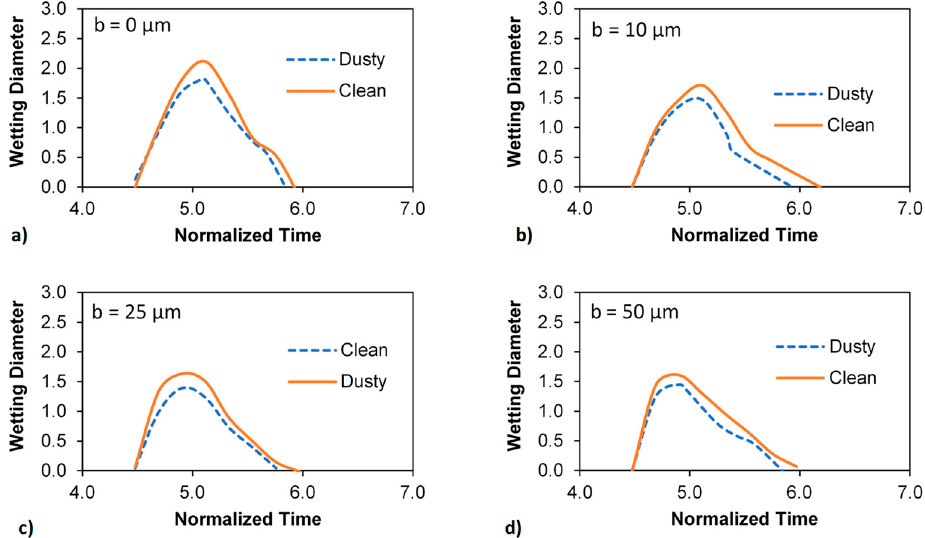
Figure 16. Variation of droplet wetting diameter with normalized time for impacting droplet on clean and dusty surfaces for various micro-post spacings: ( a ) b = 0 µ m, ( b ) b = 10 µ m, ( c ) flat hydrophobized surface b = 25 µ m, ( d ) b = 50 µ m. Droplet volume is 10 µ L.